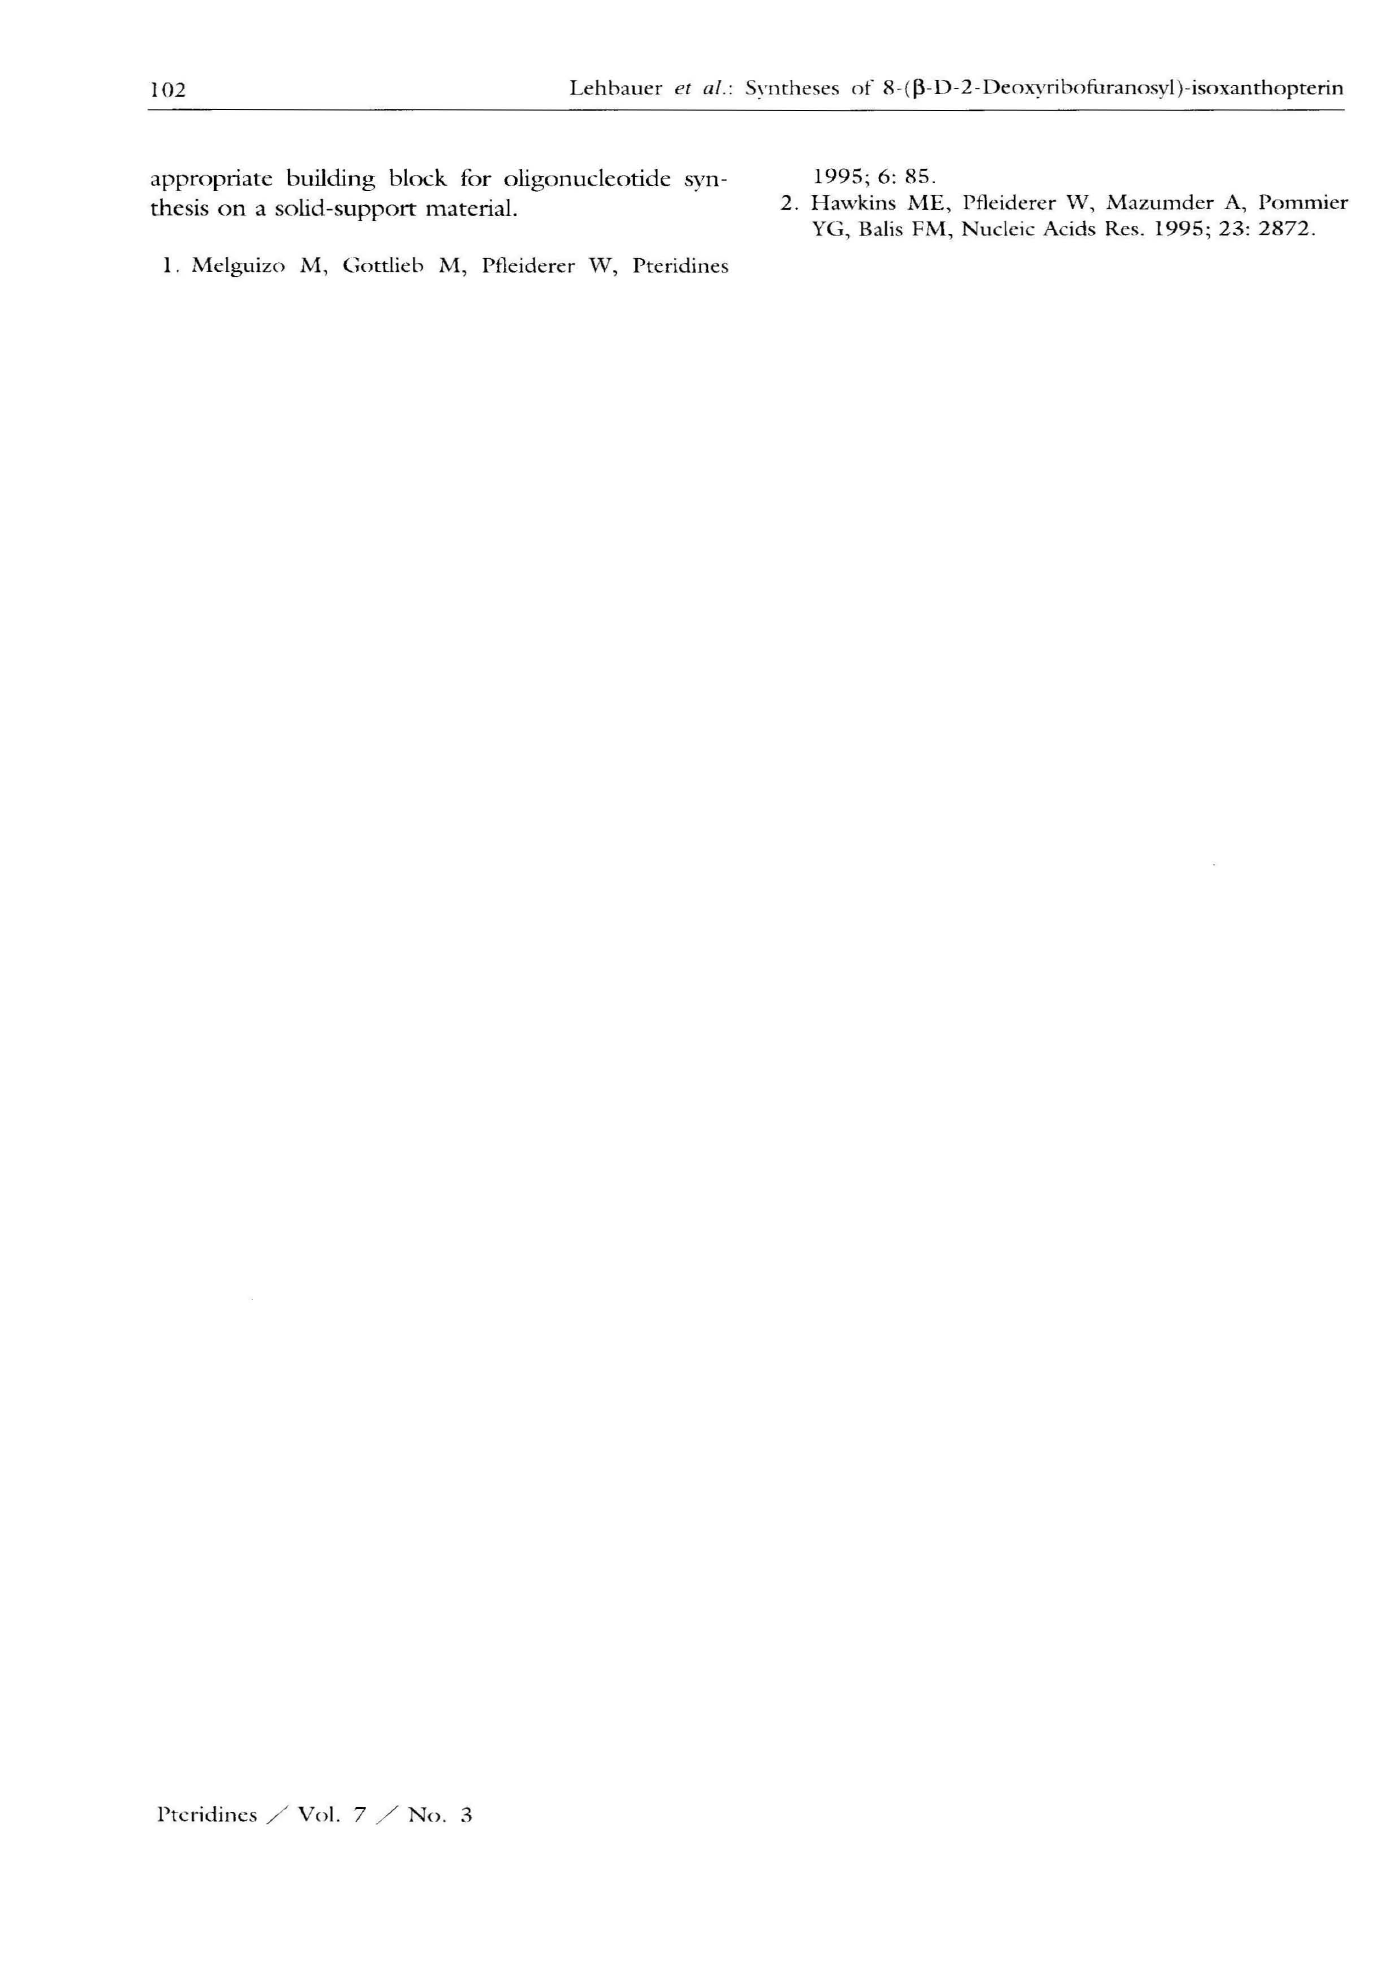
thesis on a solid-support